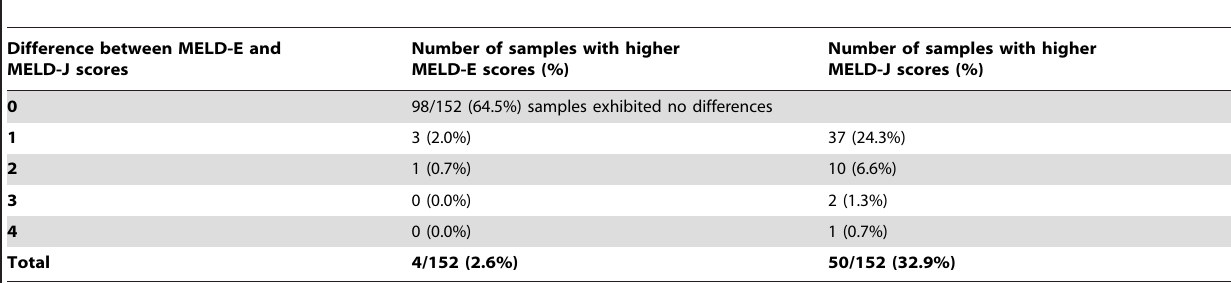
Table 3. A comparison of the creatinine measurements that were obtained enzymatically (MELD-E) and according to the Jaffe´ method (MELD-J) for samples with MELD scores . 20.